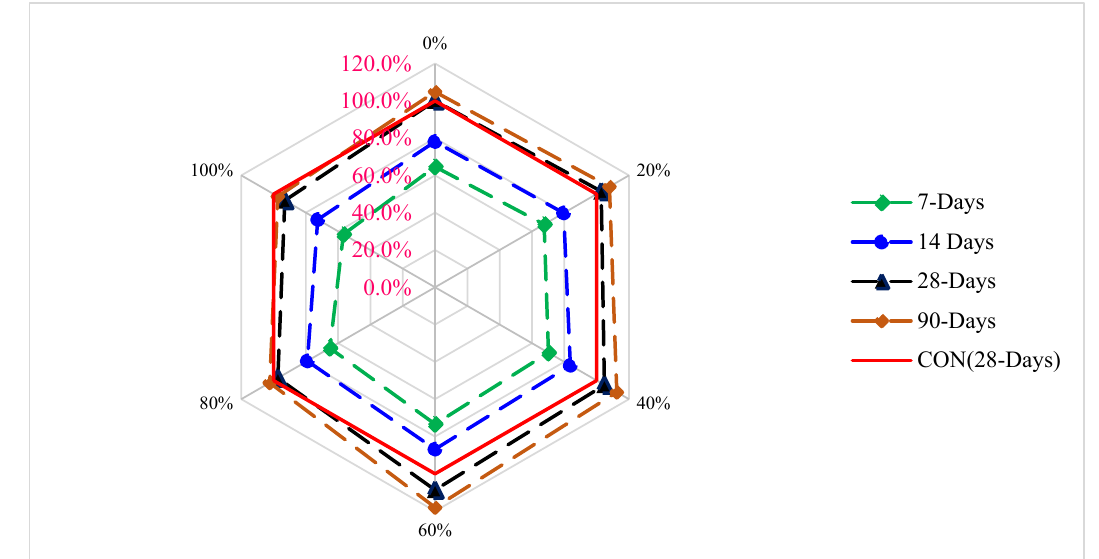
Figure 13. Relative flexural strength of concrete: data source [45].